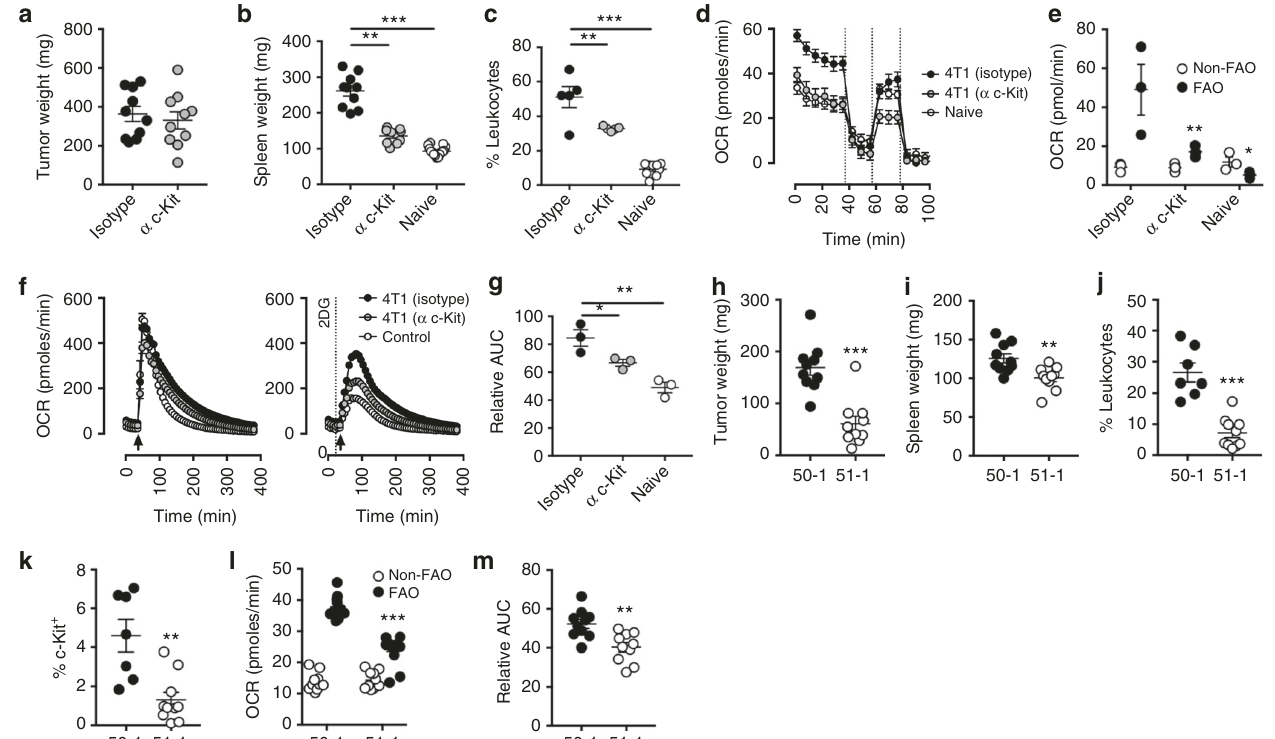
Fig. 5 SCF-c-Kit signalling drives neutrophil metabolic adaptations. a Tumour weight and b spleen weight following administration of anti-c-Kit antibody ( α